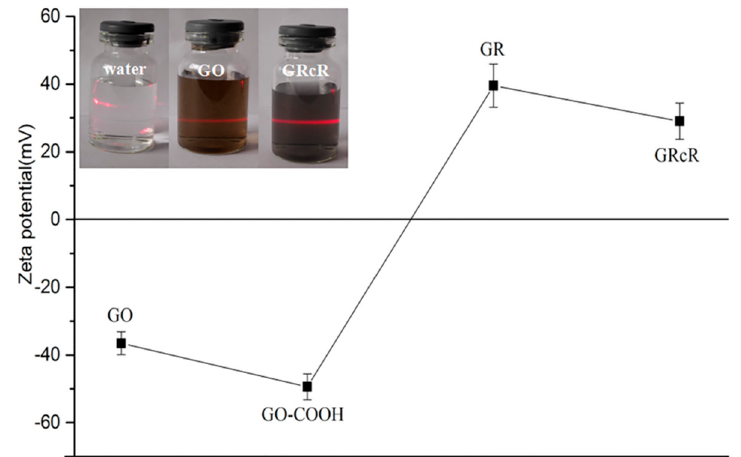
Figure 4. Tyndall effect and Zeta potential of GO, GO-COOH, GR, and GRcR. The data is presented as the mean ± SD, n = 3.